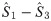
Sampled and true subpopulation areas.Illustration of three different possible sampling areas (S^1–S^3) relative to the true area (St) covered by a subpopulation.